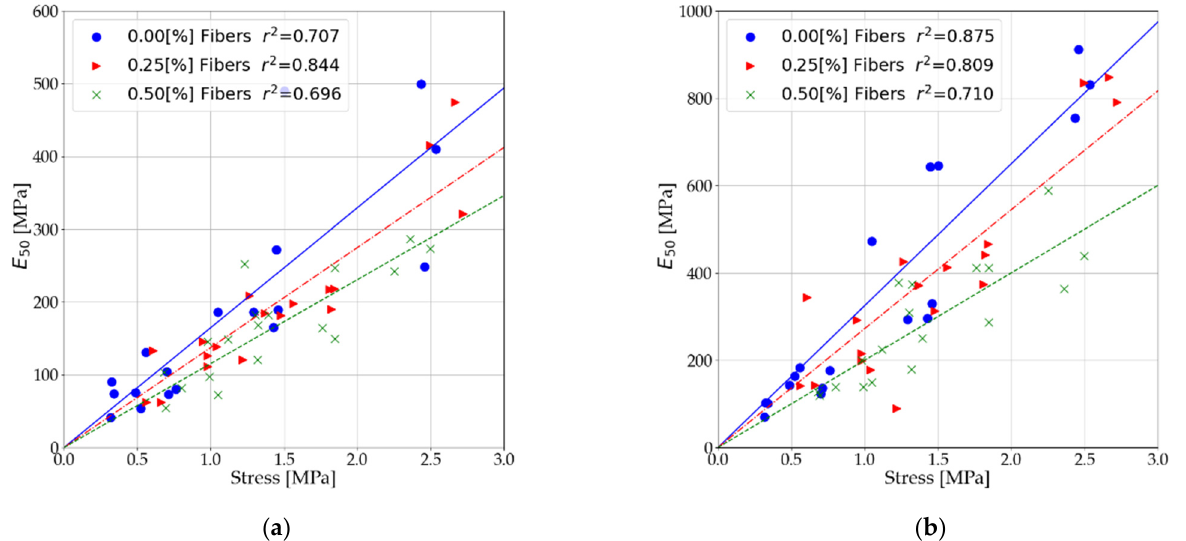
Figure 12. Influence of fibers on the relationship of secant moduli at 0.5 R c and ultimate compressive strength ( a ) before interpretation of measurement data and ( b ) after interpretation of measurement data.